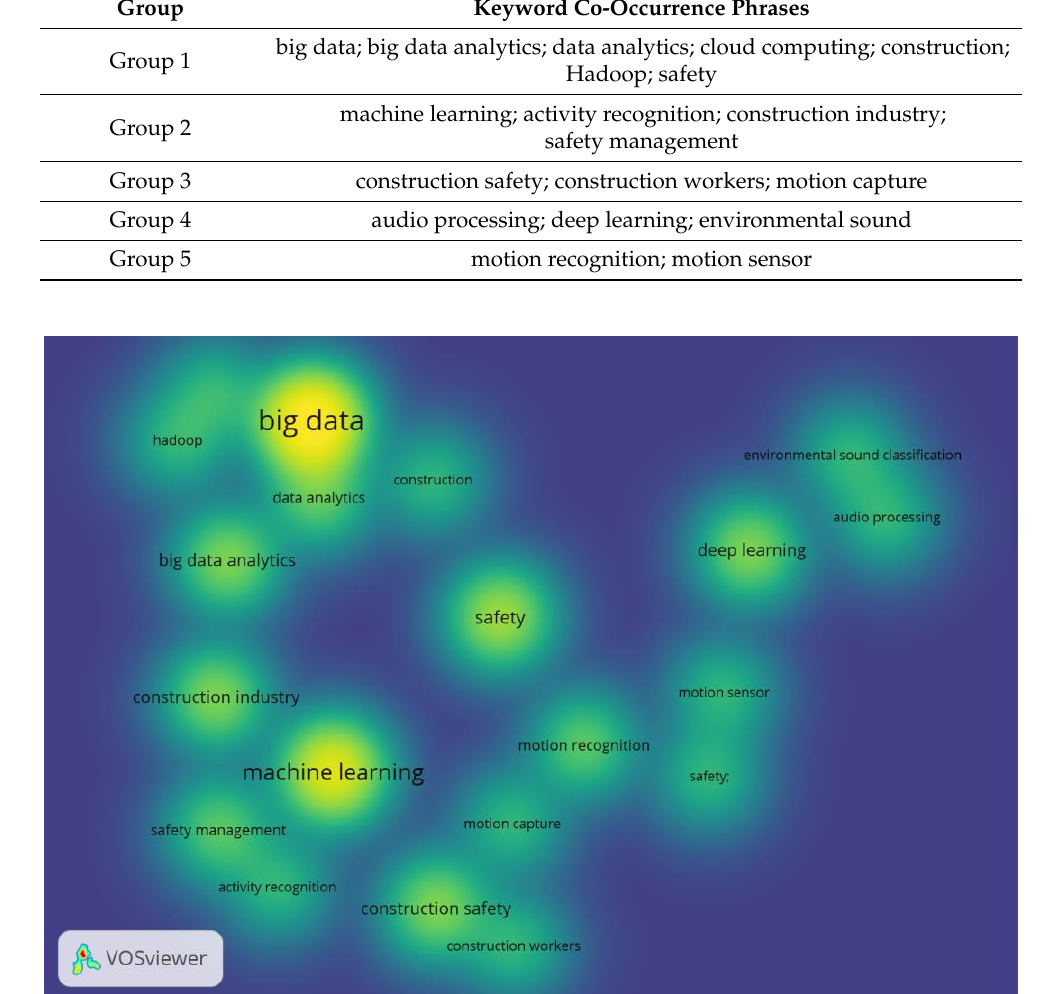
Table 2. Keyword co-occurrence phrase summary.